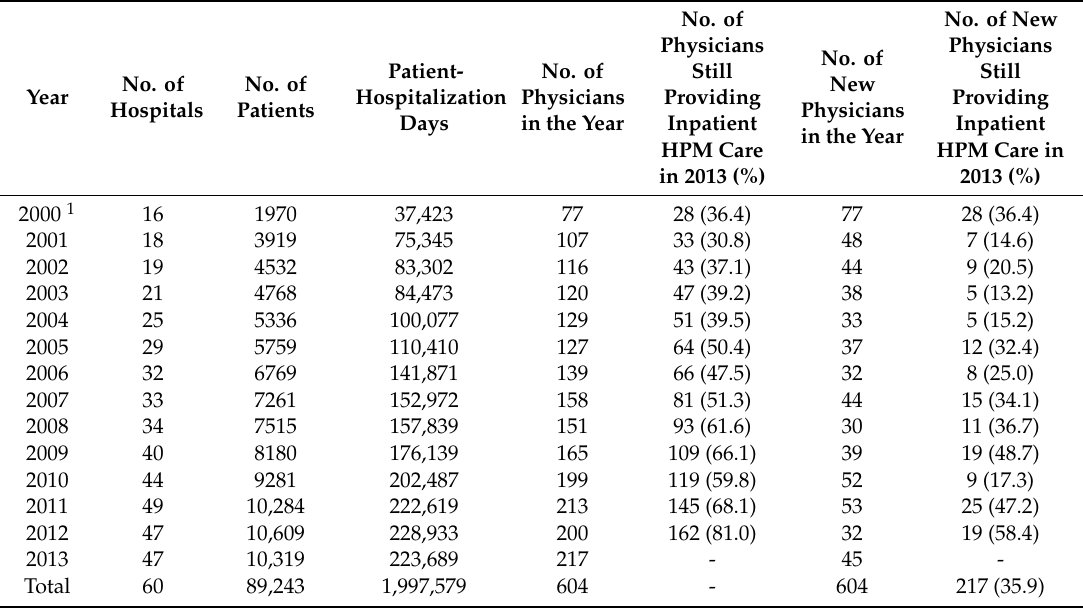
Table 1. Characteristics of inpatient hospice and palliative care from 2000 to 2013 in